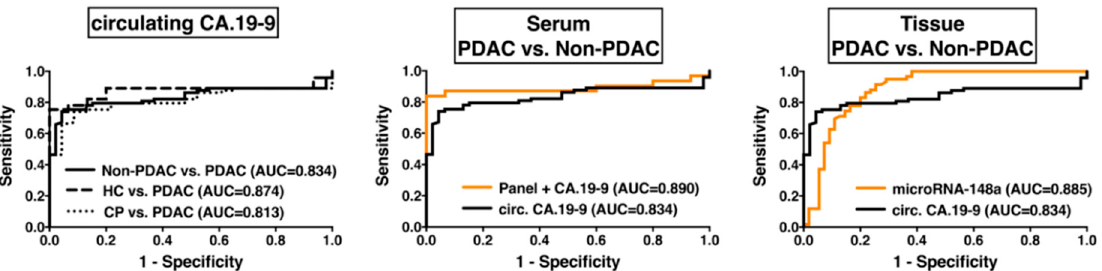
Figure 4. Diagnostic potential of EMT-microRNAs by receiver-operating-characteristic (ROC) analysis in tissue and blood serum samples of PDAC Union internationale contre le cancer (UICC) Stages II-IV. In blood serum, circulating microRNA-200b (AUC = 0.869; p < 0.001), microRNA-200c Table 2. Diagnostic performance of single EMT-miRs and CA.19-9 in discriminating PDAC from Non- PDAC. Values are calculated by ROC analysis. p ≤ 0.05 indicates significance.